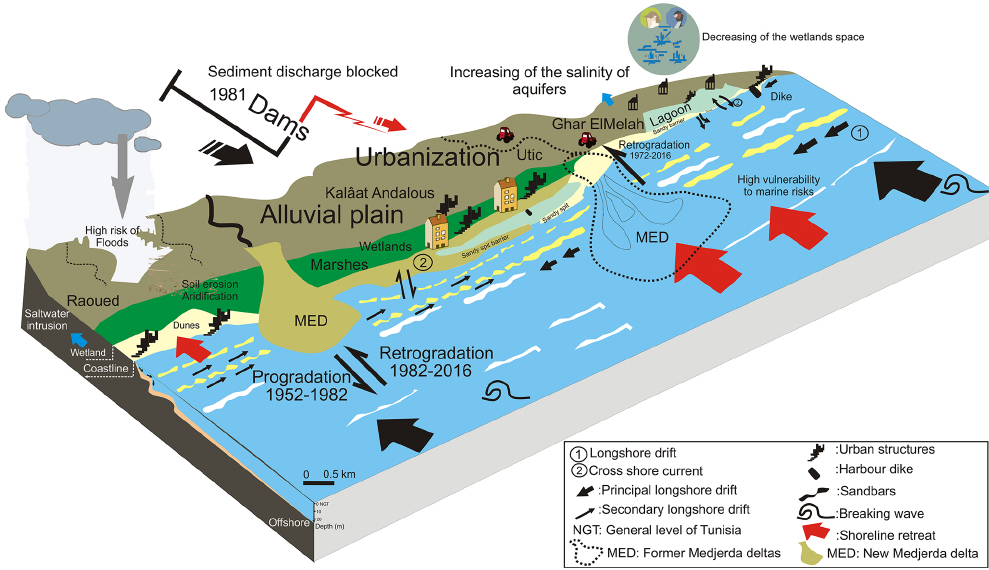
Figure 3. Environmental implication of the dam infrastructure on North African coasts ecosystems.